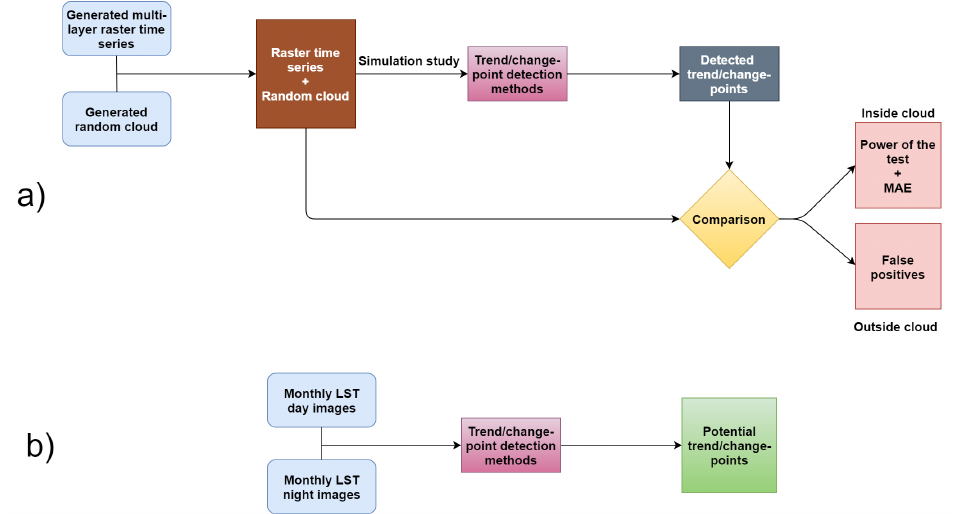
Figure 1. Flowchart for ( a ) the simulation study, and ( b ) the real data analysis.